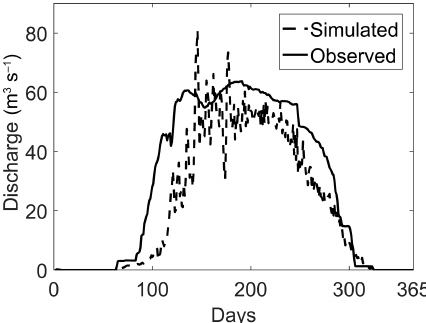
Figure 5. Simulated irrigation amount and the observations aver- aged over the years 2006–2013 at the New York Canal. The solid line shows the observed daily discharge rate in m 3 s − 1 and the dashed line shows the simulated discharge in m 3 s − 1 .